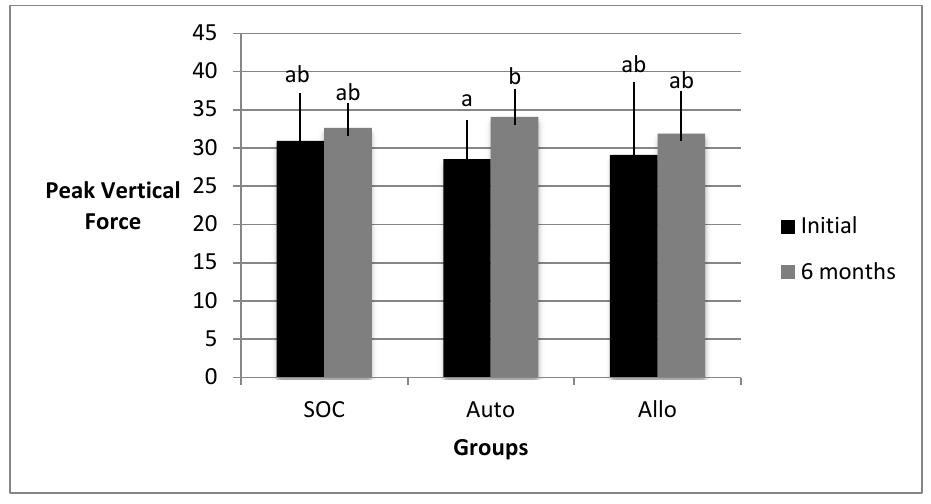
Figure 3: Comparison of peak vertical force between initial and follow-up assessments. Average peak vertical force, corrected for body weight, depicted on the y- axis, with each treatment group depicted on the x-axis. Initial assessment (black) and 6-month assessment (grey) are depicted side by side for each treatment group. Treatments consisted of standard of care (SOC), autologous (Auto) or allogeneic (Allo) cell therapies. Letters above columns are to distinguish statistical significance. Columns labeled with the same letter indicate no statistical significance between scores. Columns that do not share a common alphabetic letter are p<0.05 and are considered statistically